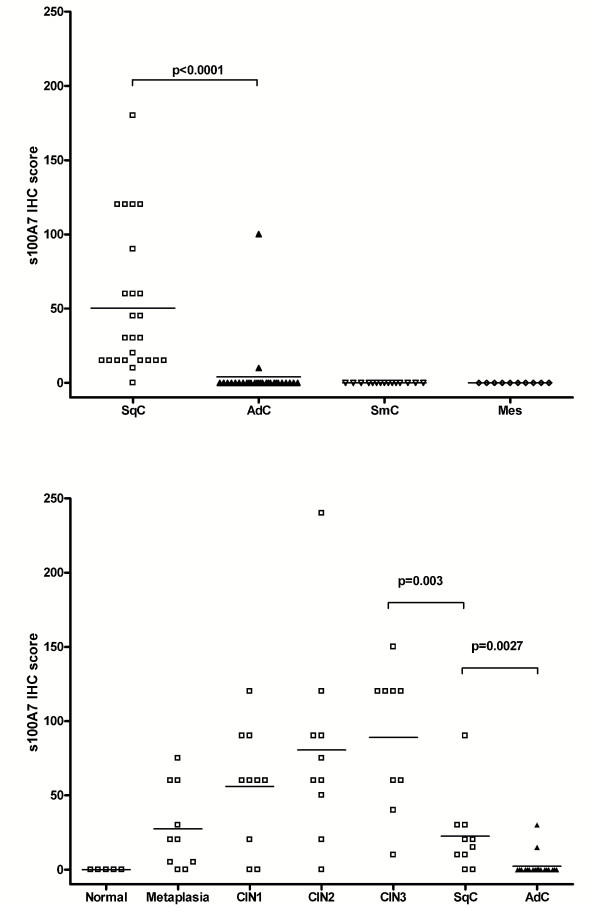
Expression of psoriasin in human lung and cervical tumors determined by immunohistochemistry Upper panel shows the scatter plot chart of level of expression (assessed by IHC score) in different lung tumor types (SqC = squamous cell carcinoma, AdC = adenocarcinoma, SmC = small cell carcinoma, Mes = mesothelioma). Bars represent the median scores. P value determined by t-test. Lower panel shows the scatter plot chart of level of expression (assessed by IHC score) in different cervical lesions corresponding to early stages of cervical tumor progression (metaplasia, CIN = cervical intra-epithelial squamous neoplasia, stages 1, 2, and 3, SqC = squamous cell carcinoma invasive, AdC = cervical adenocarcinoma, in-situ and invasive). P values determined by t-test.